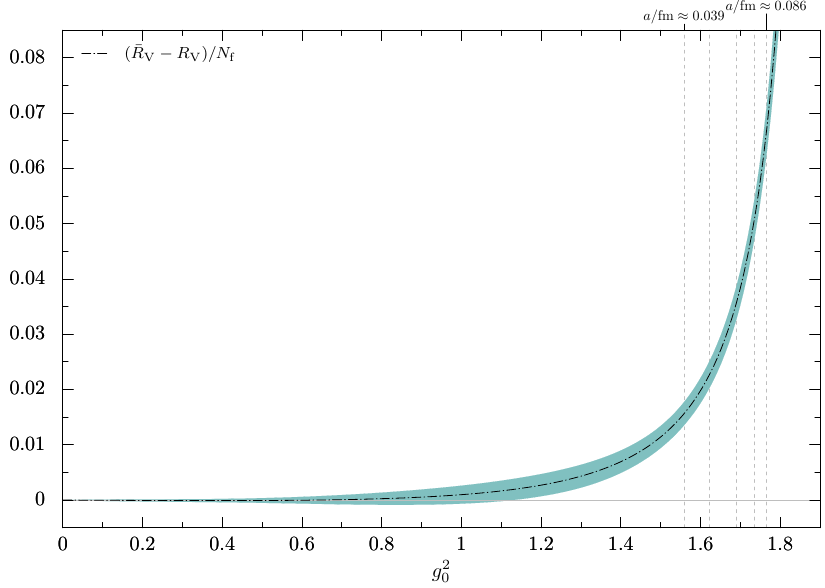
Figure 4. Sea quark mass-improvement coe(cid:14)cient (cid:22) b